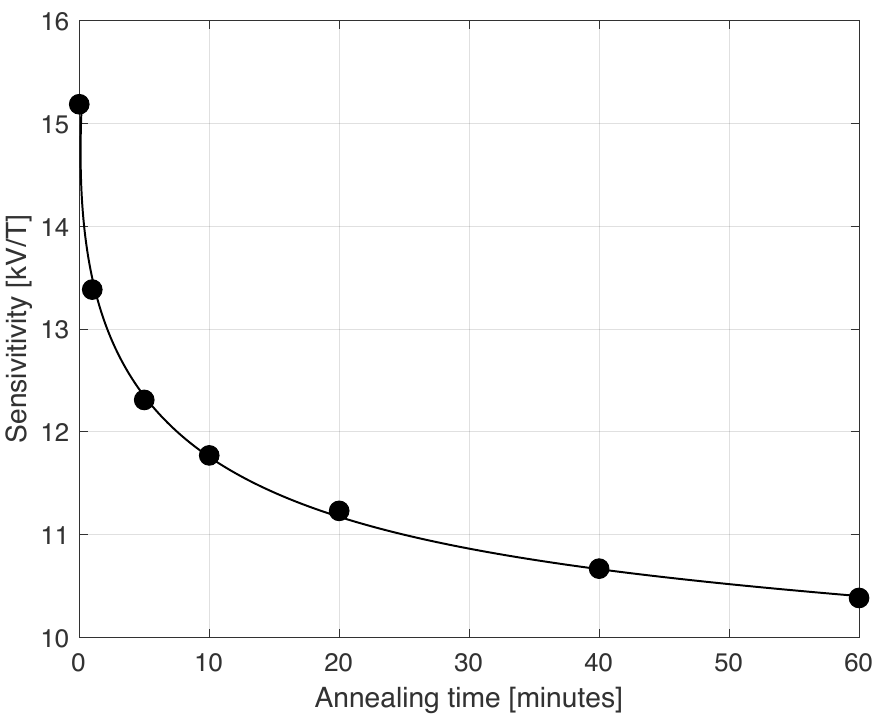
Figure 3. Sensitivity of the magnetometer before amplification for an orthogonal fluxgate in funda- mental mode based on a single wire vs. annealing